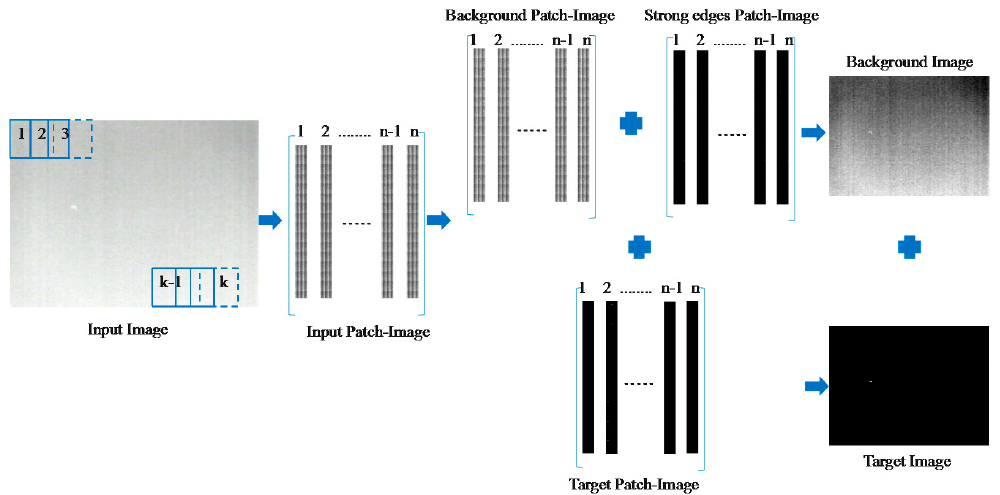
Figure 3. The overall procedure of the roposed model in this paper.